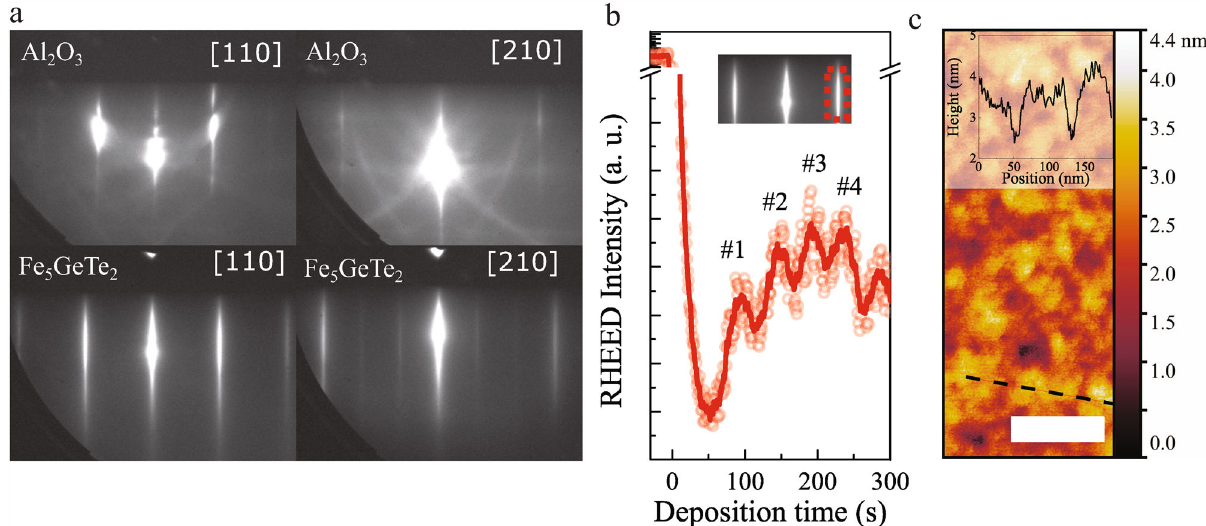
Fig. 1 Surface characterization of Fe 5 GeTe 2 . a RHEED patterns of the surface before and after the deposition of a 12 nm-thick fi lm of Fe 5 GeTe 2 along the [110] and [210] azimuths. b RHEED intensity oscillations of the (010) streak. The solid line is a moving average of the raw scatter data. Monolayer number identi fi ed on each oscilation. c Atomic force microscopy image of a 12 nm-thick fi lm; scale bar 100 nm. Inset: Height pro fi le showing resolved monolayer steps (1 ML ~ 0.977 crystal structure. Superconducting quantum interference device (SQUID), and X-ray magnetic circular dichroism measurements